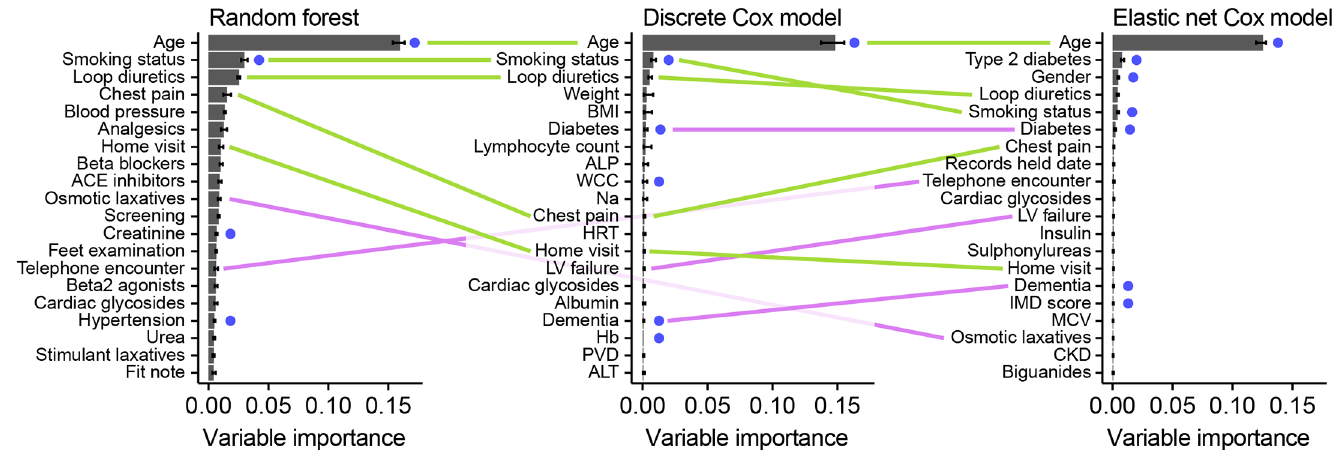
Fig 5. Top 20 variables by permutation importance for the three data-driven models, using random survival forests, discrete Cox modelling and elastic net regression. Variables which are either identical or very similar to those found in the expert-selected dataset are highlighted with a blue dot; variables appearing in two of the models are joined by a pink line (with reduced opacity for those which pass behind the middle graph); whilst variables appearing in all three are joined by green lines. Some variable names have been abbreviated for space: ACE inhibitors = angiotensin-converting enzyme inhibitors; ALP = alkaline phosphatase; analgesics = non-opioid and compound analgesics; ALT = alanine aminotransferase; Beta2 agonists = selective beta2 agonists; blood pressure = diastolic blood pressure; BMI = body mass index; CKD = chronic kidney disease; Insulin = intermediate- and long-acting insulins; LV failure = left ventricular failure; Hb = haemoglobin; MCV = mean corpuscular volume; Na = sodium; PVD = peripheral vascular disease; Records held date = date records held from; WCC = total white blood cell count.